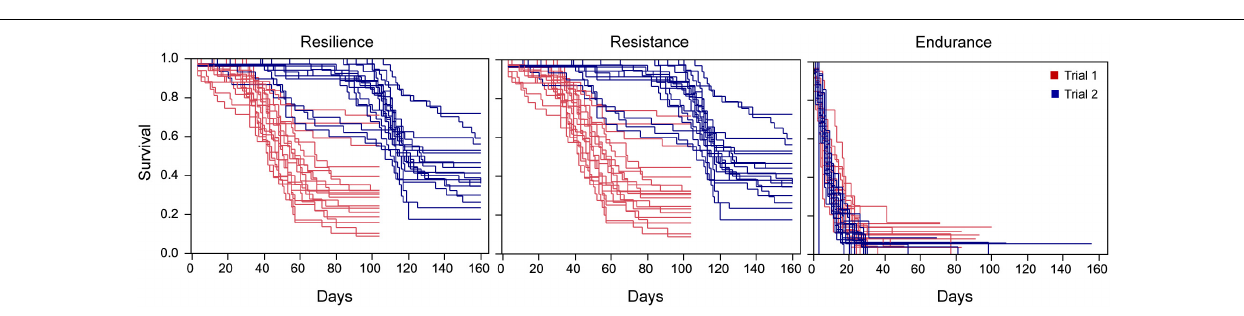
FIGURE 2 | Kaplan–Meier survival curves for trials 1 and 2 when fish are grouped by recipient families for resilience, resistance, and